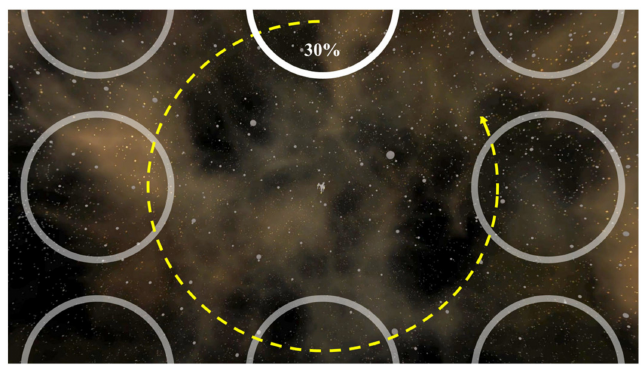
Figure 4. The fourth VR sickness reduction method (M4). The VG of the fifth VR sickness reduction method had a size 30% that of the aspect ratio, and a position synchronized to the user’s gaze movement direction. This method continuously induced the user’s gaze by positioning the VG in the user’s gaze direction. Figure 5 shows the fifth VR sickness reduction method (M5).